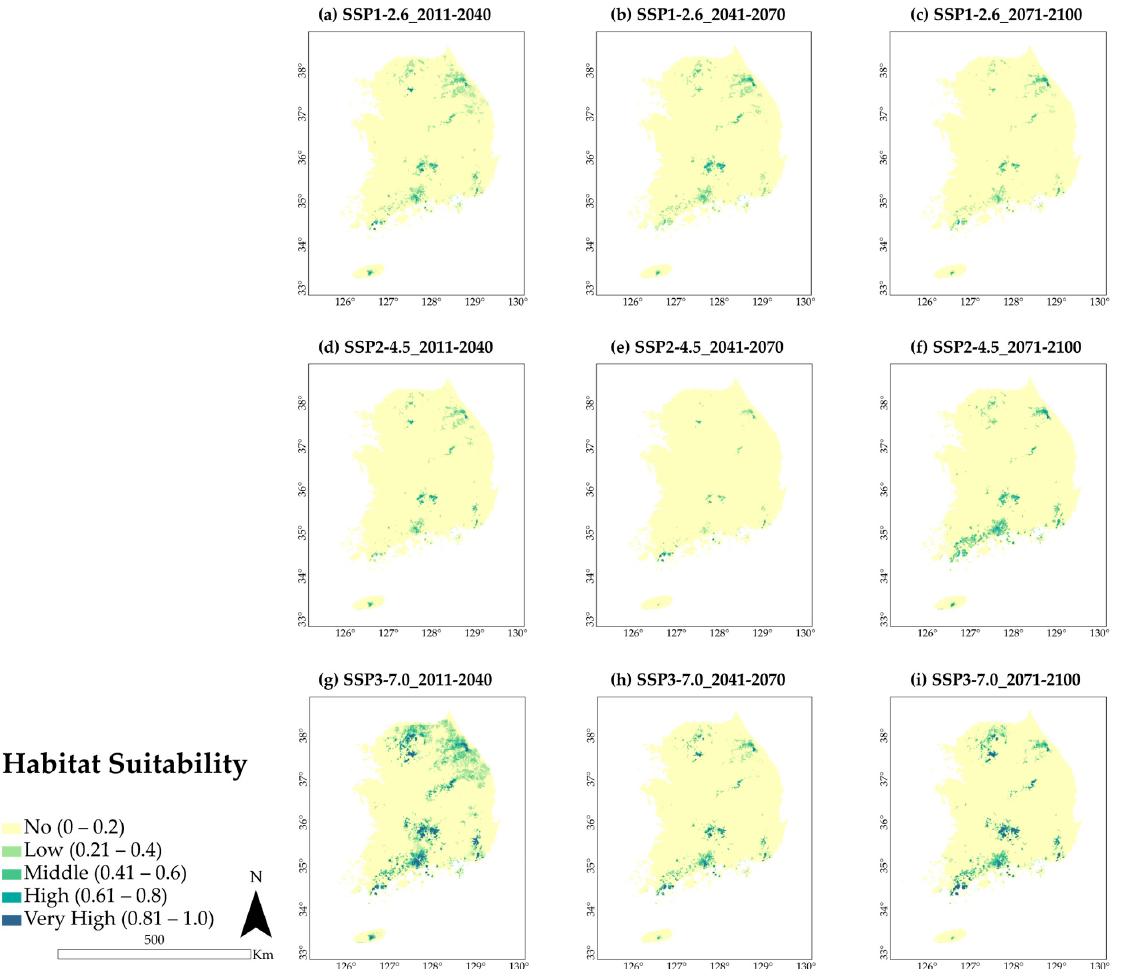
Figure A5. The potential distribution of A. pictum under future climate conditions. ( a – c ) indicate the potential distribution at three periods under SSP1-2.6, respectively; ( d – f ) indicate the potential distribution at three periods under SSP2-4.5, respectively; ( g – i ) indicate the potential distribution at three periods under SSP3-7.0, respectively.